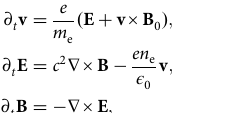
Fig. 6 Band structure when two different gaps overlap. In this case, ck z / ∣ Ω ∣ = 1.4 and the inner and outer plasma frequency are ( ω ∣ Ω ∣ = (1.4, 0.1). The bulk modes of the inner and outer plasma when k ⊥ = 0 are highlighted by orange and blue curves, respectively. The other bulk modes are indicated by gray curves. The gap between bands 1 and 2 of the inner plasma overlaps with gap between bands 2 and 3 of the outer plasma. However, this band gap is fi lled with local upper hybrid modes due to continuous density pro fi